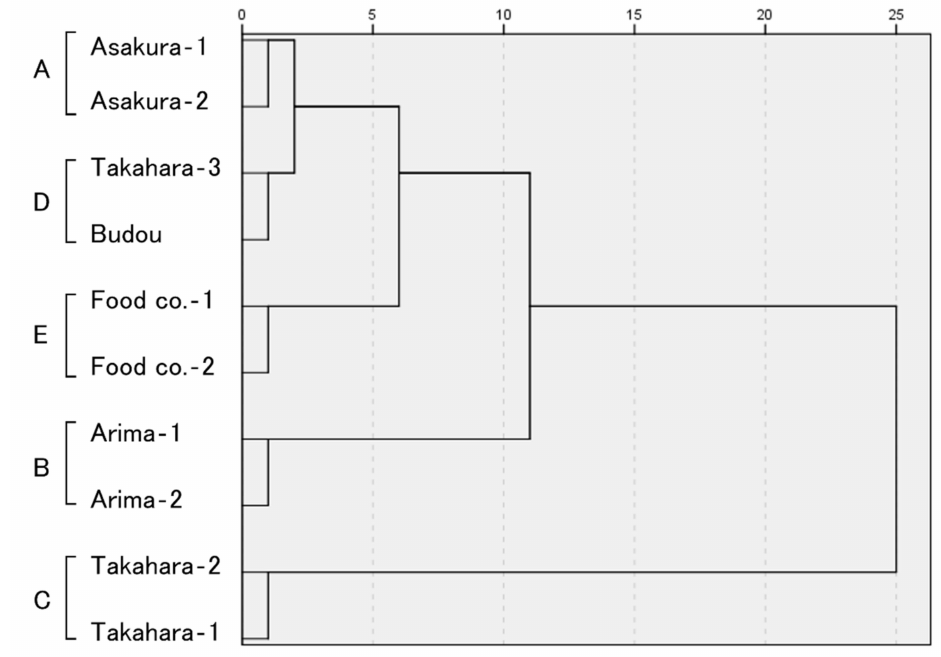
Figure 3. Dendrograms based on the volatile compounds of Japanese